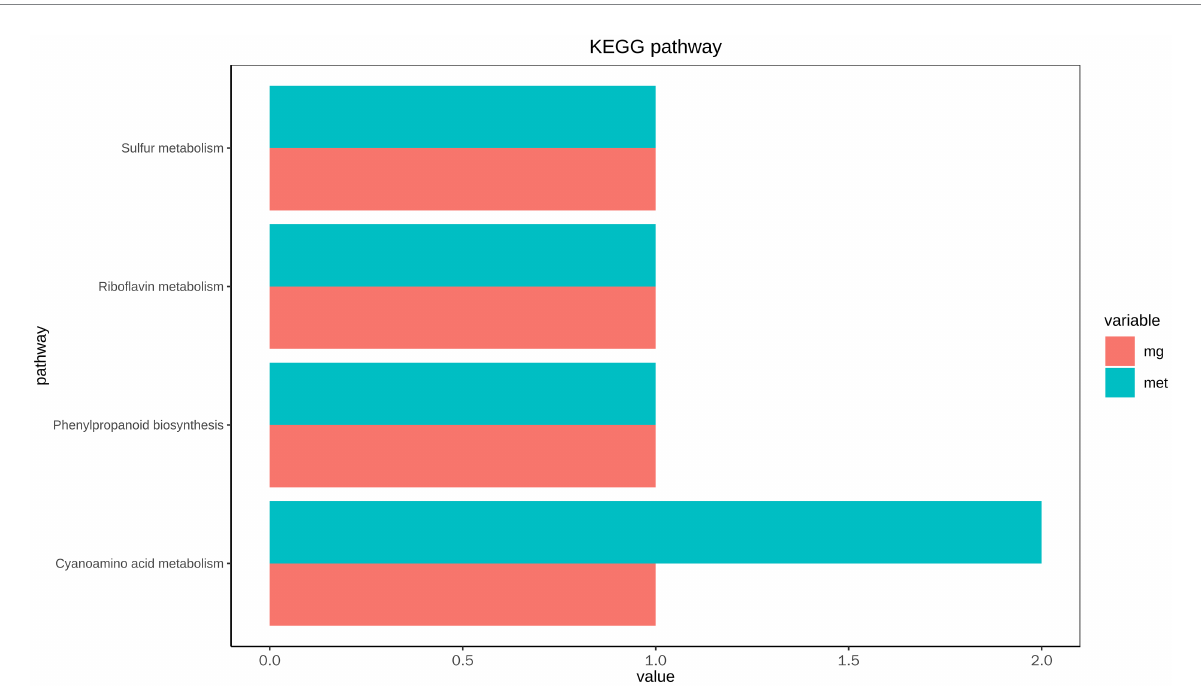
FIGURE 6 Correlation analysis of KEGG pathway of intestinal microbial metagenome and metabolome of L. vannamei .